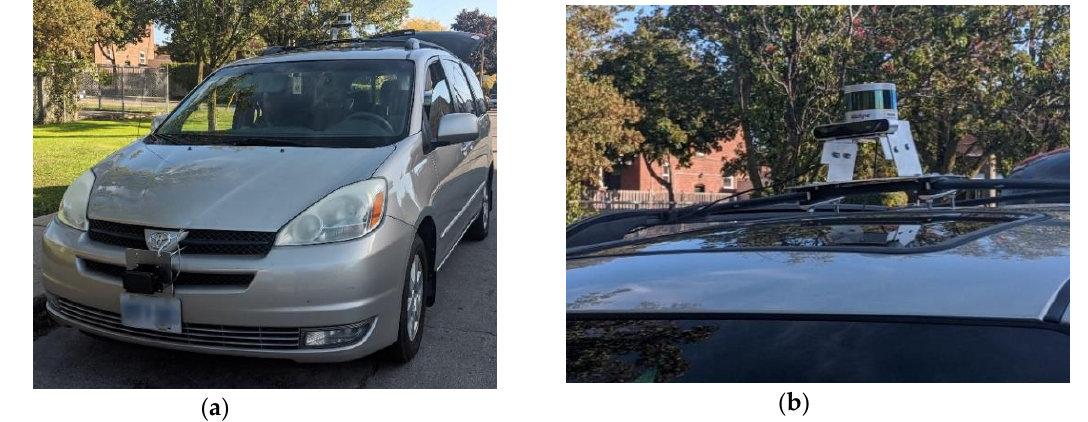
Figure 12. ( a ) Minivan Used for the Trajectories; ( b ) Sensors Mounted on the Rooftop.